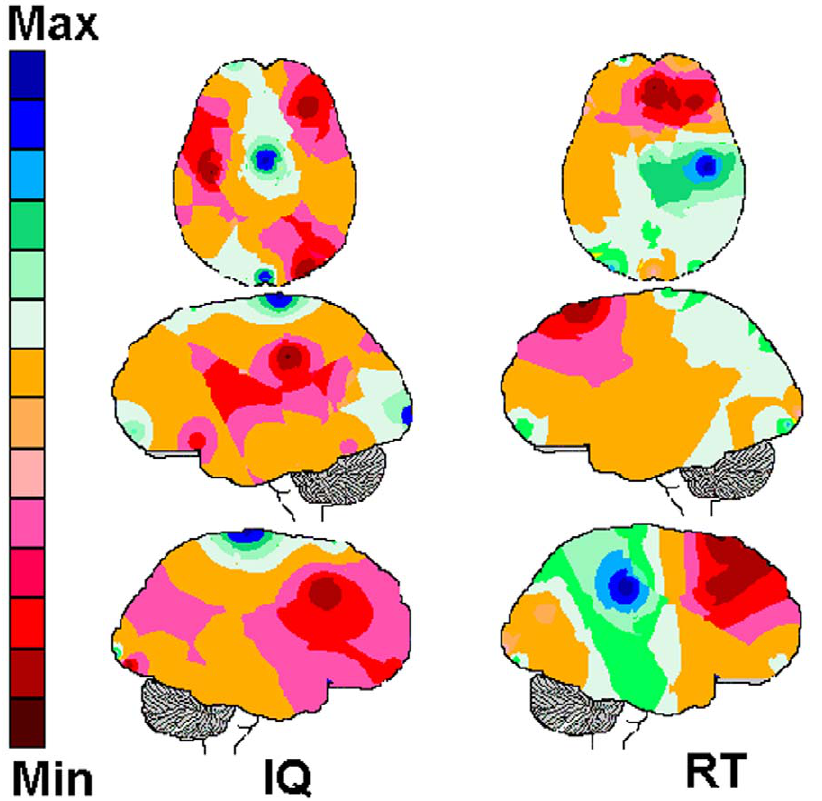
Figure 5. The EEG mappings for the calculated linear regressions. IQ ~ a z b 1 h ( e 1 ) z ::: z b 20 h ( e 20 ) and RT ~ a z b 1 h ( e 1 ) z ::: z b 20 h ( e 20 ) Light to dark blue areas are those for which b i w 0 and pink to dark red areas are those for which b i v 0 . Max and Min – maximum and minimum values for b i h ( e i ) , respectively. The Pearson’s correlation coefficient between IQ and RT mappings was 2 0.16. doi:10.1371/journal.pone.0017355.g005 PLoS ONE |